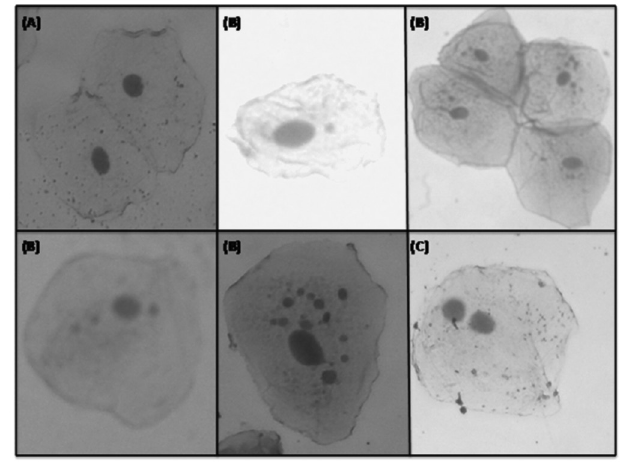
Figura 2. Teste dos Micronúcleos dos indivíduos analisados: (A) Célula sem micronúcleos; (B) Células com um ou mais micronúcleos; (C) Célula